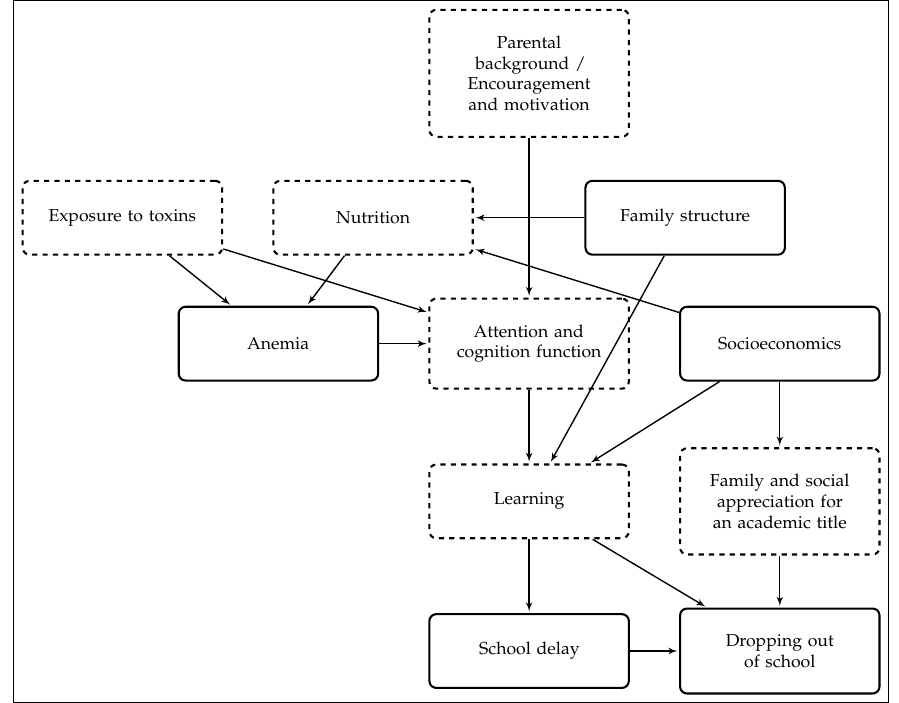
Figure 1. Causal diagram analysis of anemia and schooling outcomes. A simplifying model of how anemia, parental background, family structure, and socioeconomics could influence school delay and dropping out of school. Prepared by the